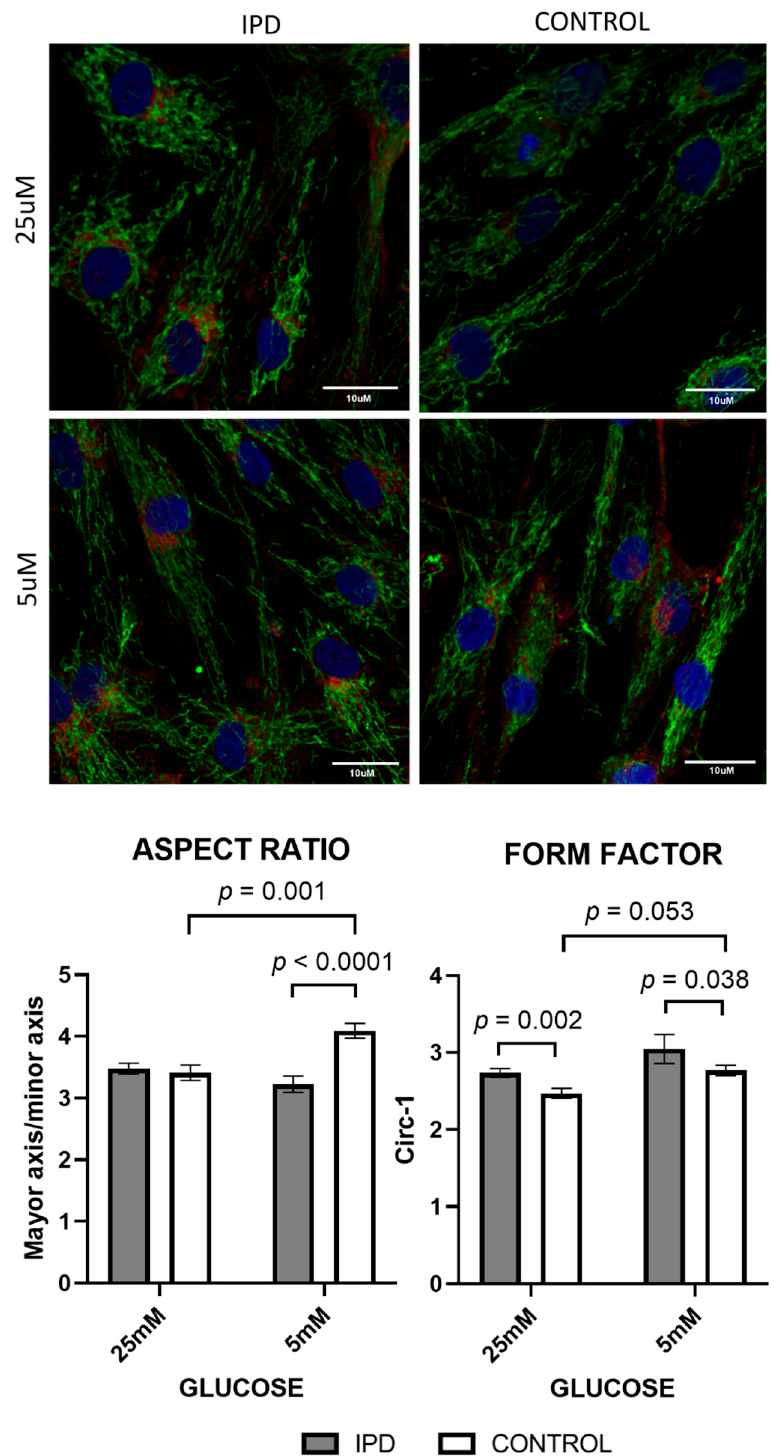
Figure 6. Mitochondrial dynamics (morphology and network) in fibroblasts of iPD patients vs. controls exposed to low or high glucose concentration (5 vs. 25 mM). Upper panel: Representative images of mitochondrial network of fibroblasts of iPD patients vs. controls, in both glucose conditions. Note the preserved mitochondrial mitochondrial porphology and network in iPD cells, compared to controls, able to adapt to di ff erent glucose concentrations. Lower panel: Mitochondrial morphology did not change in fibroblasts from idiopathic Parkinson’s disease patients (iPD, grey bars) vs. controls (C, white bars) in accordance with glucose exposition, confirming their metabolic and morphologic